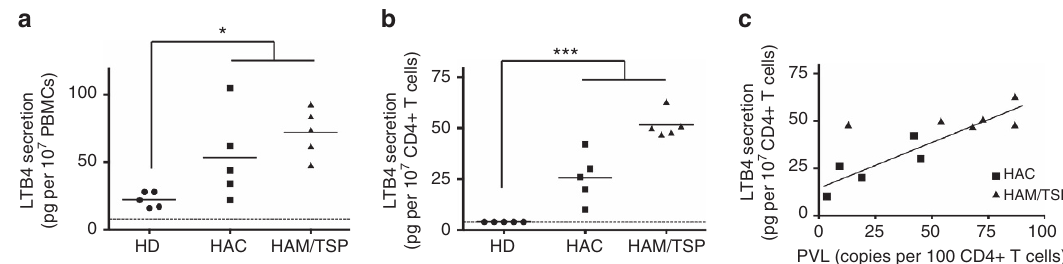
Figure 1 | Primary CD4 T cells from HTLV-1-infected individuals secrete LTB4. ( a ) PBMCs from HTLV-1-infected individuals secrete significantly more LTB4 than PBMCs from HDs. PBMCs were culture for 30min and spontaneous LTB4 secretion levels were determined by ELISA. Dashed line represents the detection limit of the ELISA kit. PBMCs were from HDs ( n ¼ 5), HACs ( n ¼ 5) or individuals who had developed HAM/TSP ( n ¼ 5). Bars represent mean. P value ¼ 0.03; Mann–Whitney U -test (HDs versus HACs and HAM/TSP). ( b ) CD4 T cells from HTLV-1-infected individuals secrete detectable levels of LTB4. CD4 T cells were isolated, cultured for 30min and spontaneous LTB4 secretion was detected by ELISA. Bars represent mean. P value o 0.001; Mann–Whitney U -test (HDs versus HACs and HAM/TSP). ( c ) LTB4 spontaneous secretion by CD4 Tcells correlates with the percentage of cells infected with HTLV-1. Pearson’s correlation test: r ¼ 0.87; R 2 ¼ 0.76; P value o 10 (cid:2) 4